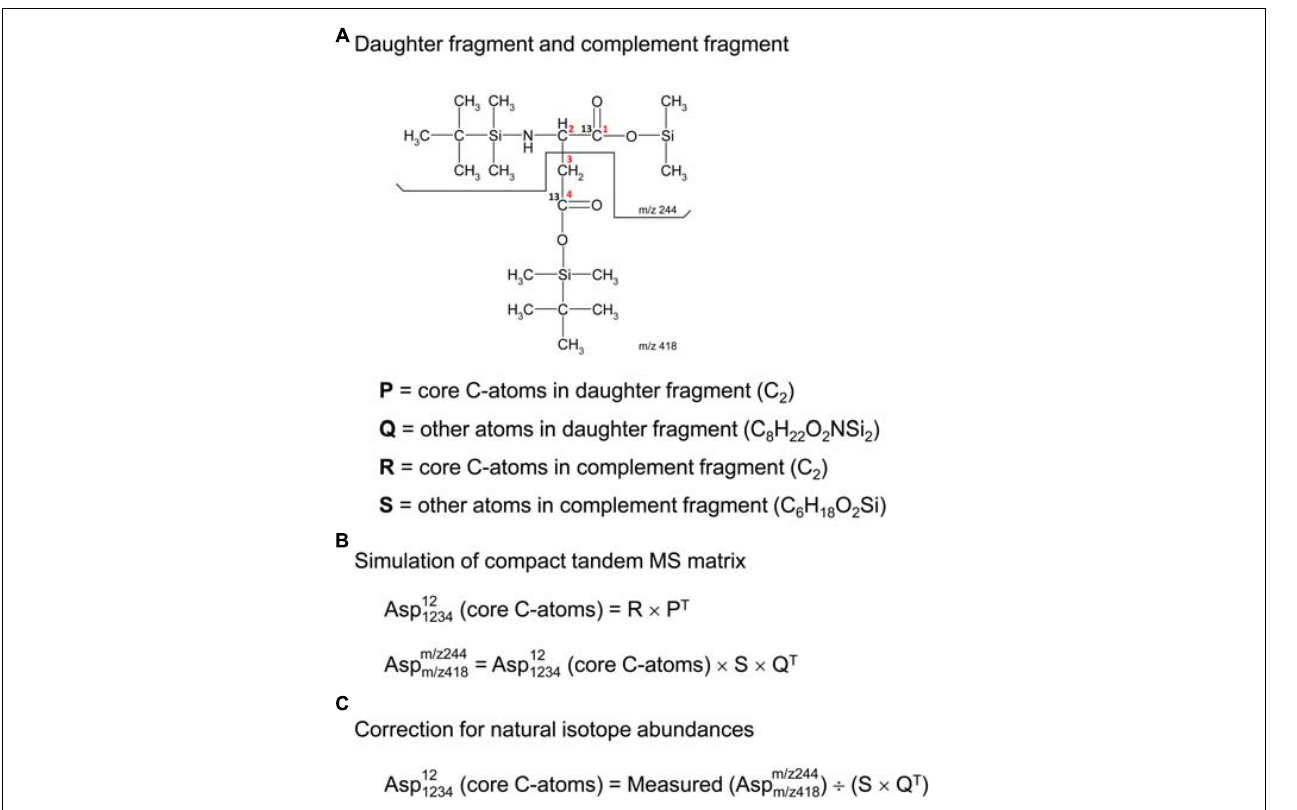
FIGURE 2 | (A) Definitions of daughter fragment and complement fragment; here, illustrated for TBDMS-derivatized aspartate, where the daughter fragment contains carbon atoms C1 and C2 of aspartate, and the complement fragment contains carbon atoms C3 and C4 of aspartate. (B) The compact tandem MS matrix of TBDMS-derivatized aspartate is simulated using 2D-convolutions (denoted by “ × ”), where Q and S are the natural abundance MID vectors for the other atoms (i.e., non-core C-atoms) of the daughter and complement fragments, respectively. (C) Correction for natural isotope abundances of non-core C-atoms is accomplished by a 2D-deconvolution (denoted here by “ ÷